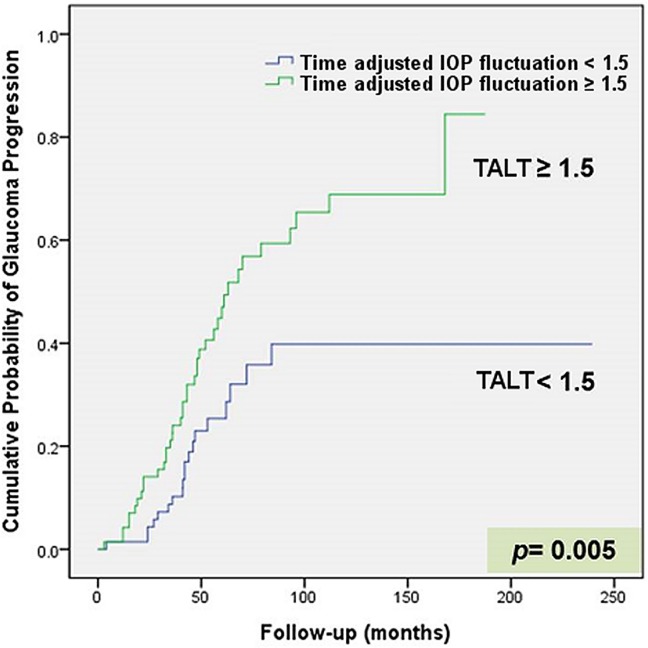
Kaplan-Meier curve showing the cumulative probability of glaucoma progression in patients with NTG.With time adjusted long-term IOP variation (TALT), the group with long-term IOP fluctuation of >1.5 mmHg had a higher cumulative probability of glaucoma progression than the group with standard deviation of IOP < 1.5 mmHg (P = 0.005, log-rank test).